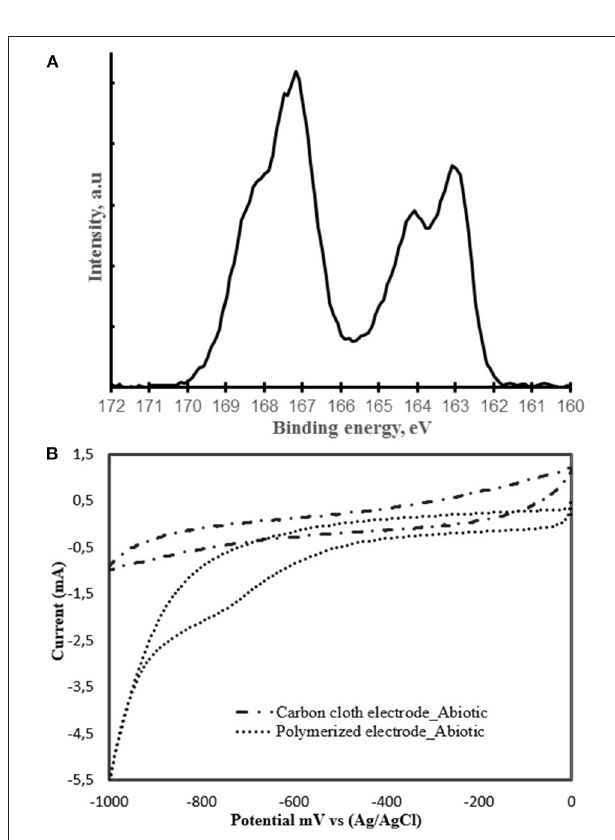
FIGURE 2 | (A) S(2p) XPS spectrum of PEDOT:PSS-carbon cloth electrode. (B) Cyclic voltammograms of carbon cloth and PEDOT:PSS-carbon cloth electrode (polymerized) in sterile 311 medium. Scan rate of 1mV s − 1